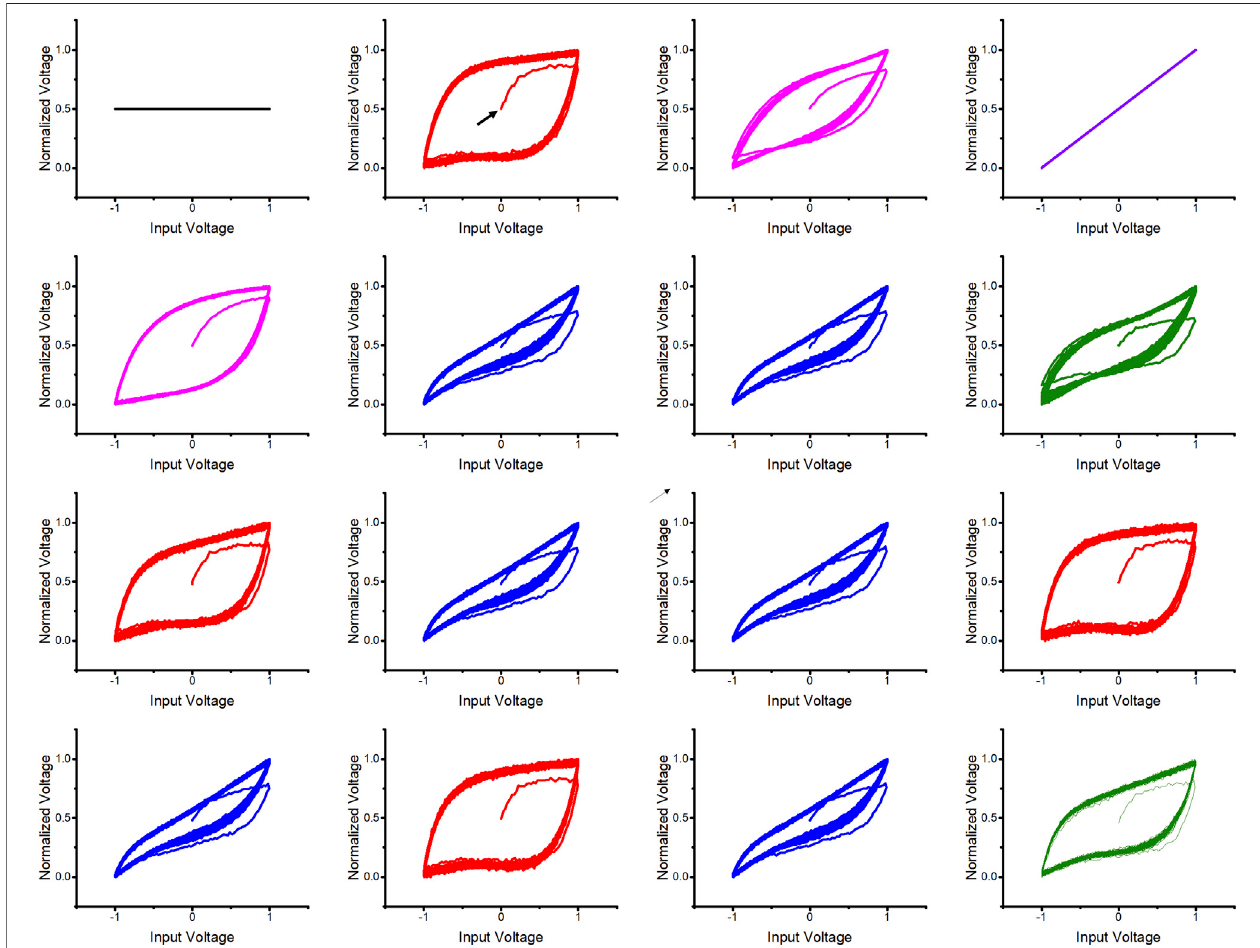
FIGURE6| RepresentativenormalizedLissajousplotsofall16electrodesmeasuredsimultaneouslyusinga7 Hztrianglewaveformsweptfrom – 1to+1 Voverthe course of 23 s with the grounded electrode (top left) and input signal (top right) recorded. Different colors correspond to different emergent dynamics spatially distributed throughout the network. The fi rst sweep can be seen in all plots as indicated by the black arrow. The network demonstrated a spatially diverse system with reproducible, non-linear behavior distributed throughout the networks.